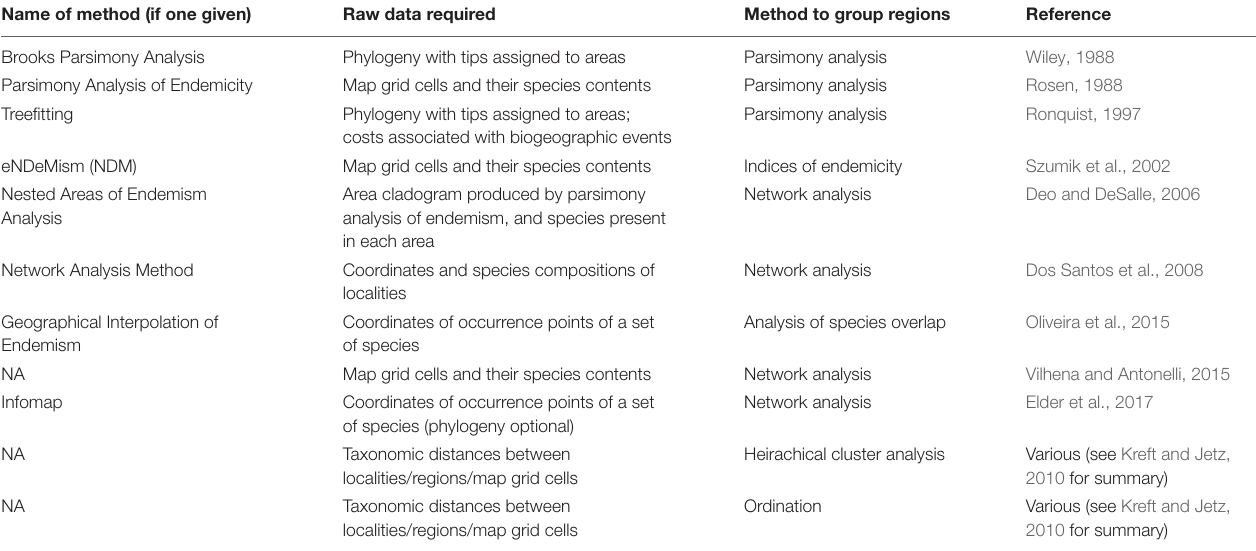
TABLE 1 | Examples of quantitative methods for identifying areas of